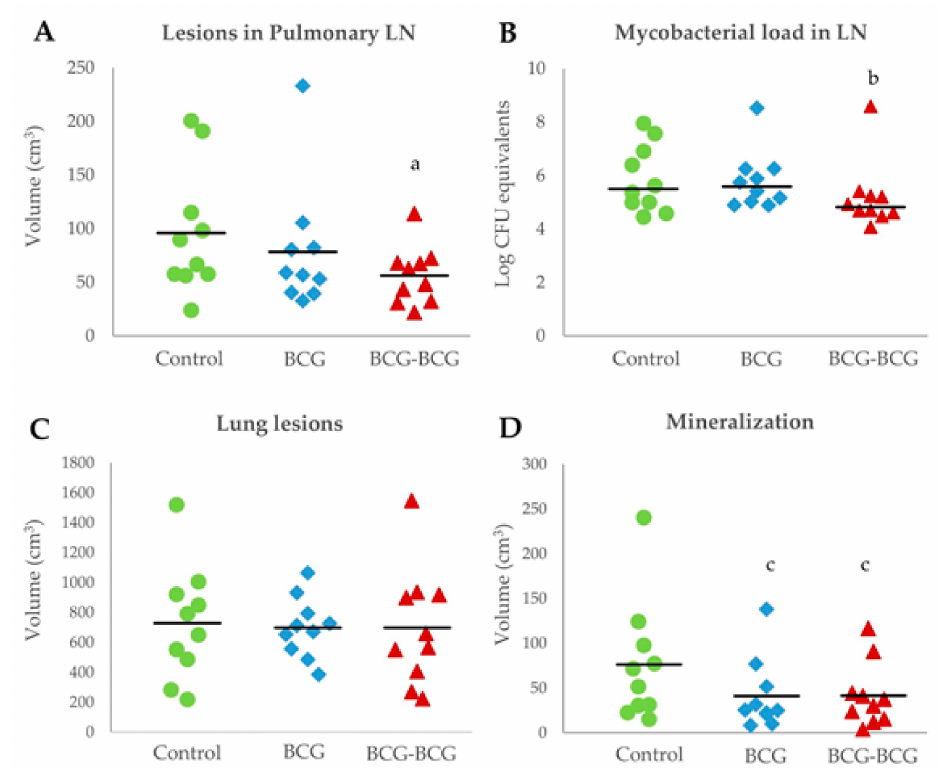
Figure 6. Postmortem analyses. ( A ) Volume of tuberculous lesions in pulmonary lymph nodes (LN). BCG (blue): single BCG-vaccinated group, BCG-BCG (red): BCG revaccinated group, Control (green):